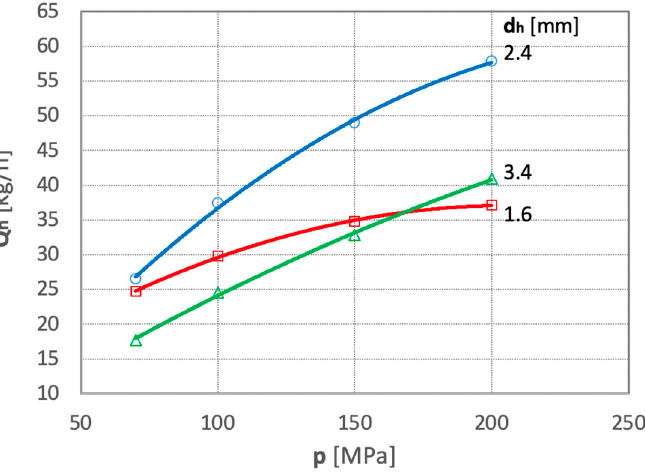
Figure 9. Dependence of the efficiency of polymetallic nodule comminution as a function of water pressure for several comminuting-homogenizing tubes of different diameters (for d w = 0.7 mm and s = 10 mm).